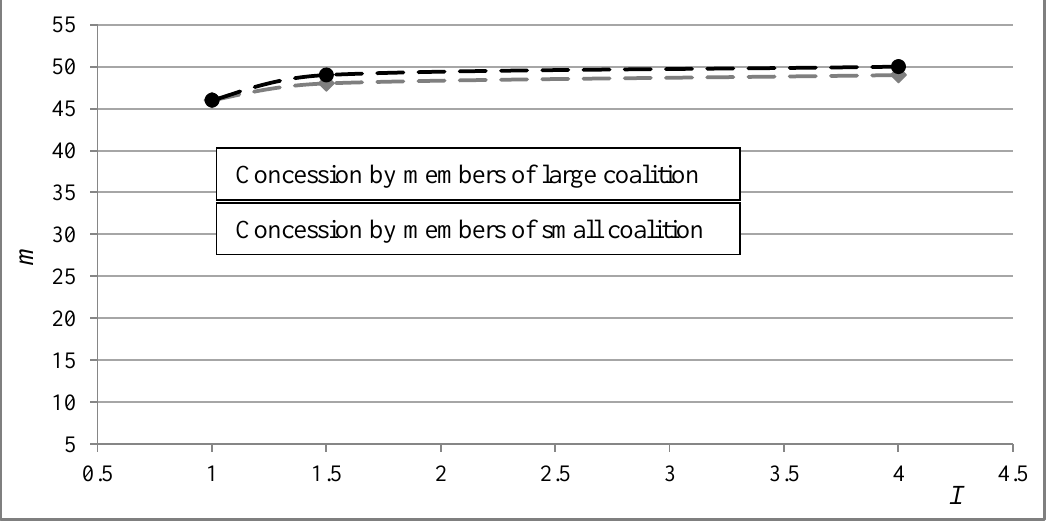
Figure 3. Dependence of the average number of negotiations m from coalition influence index I, while uni- lateral concessions Y=